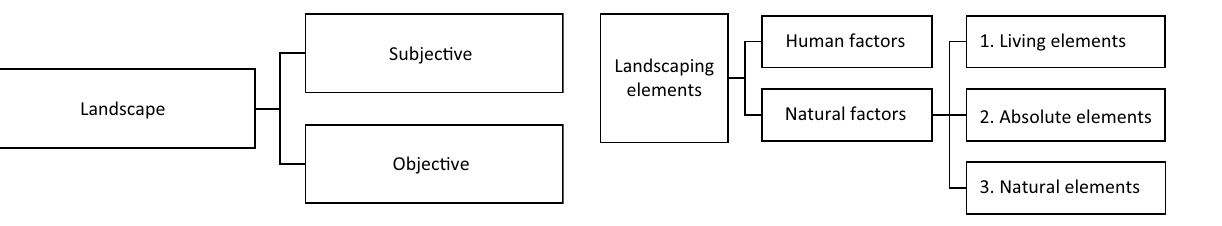
fig. 8. landscaping elements (Seifoddini